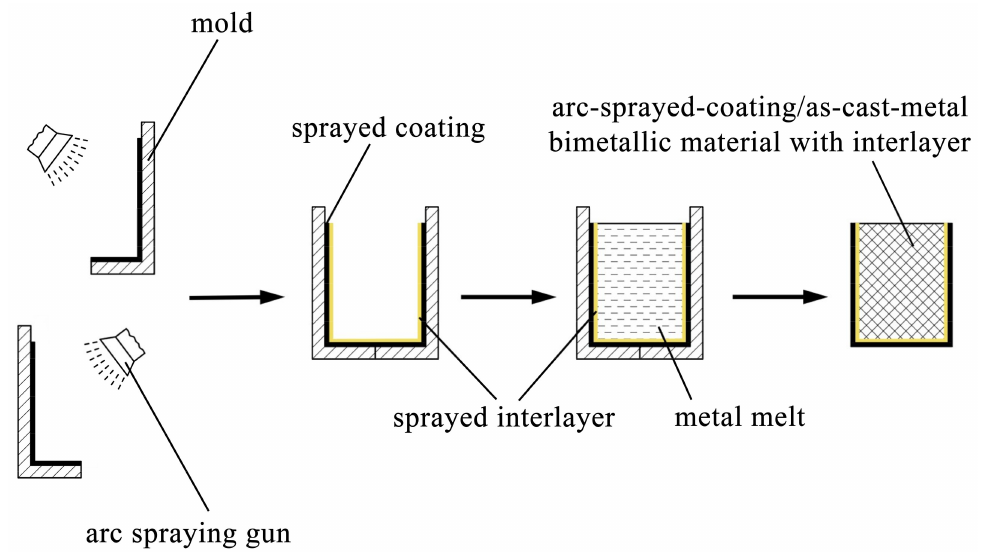
Figure 1. Schematic diagram of outer cladding by SLCC with a metallic